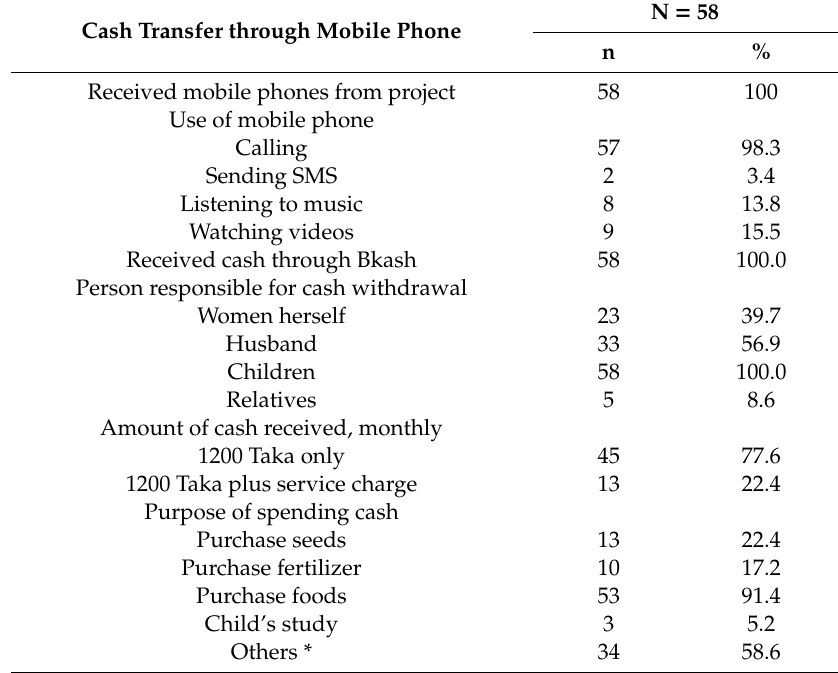
Table 5. Feasibility of cash transfer through mobile